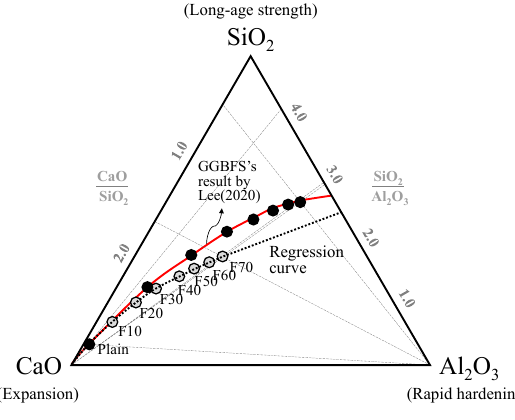
Figure 16. CaO/SiO 2 and SiO 2 /Al 2 O 3 molar rates in terms of the mixing rate. Figure 16. CaO / SiO 2 and SiO 2 / Al 2 O 3 molar rates in terms of the mixing